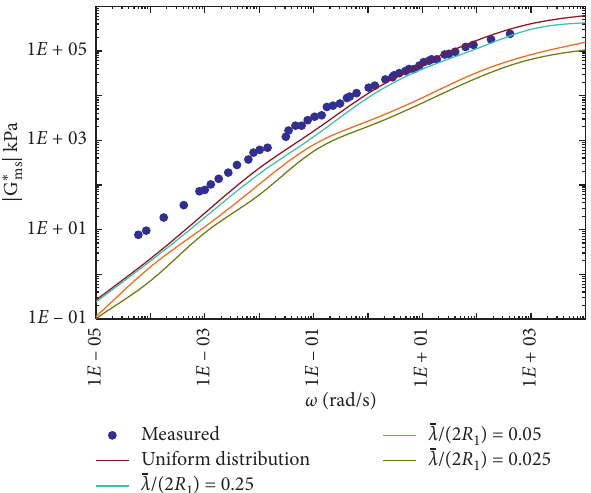
Figure 9: Effect of fillers distribution on the predicted | G ∗